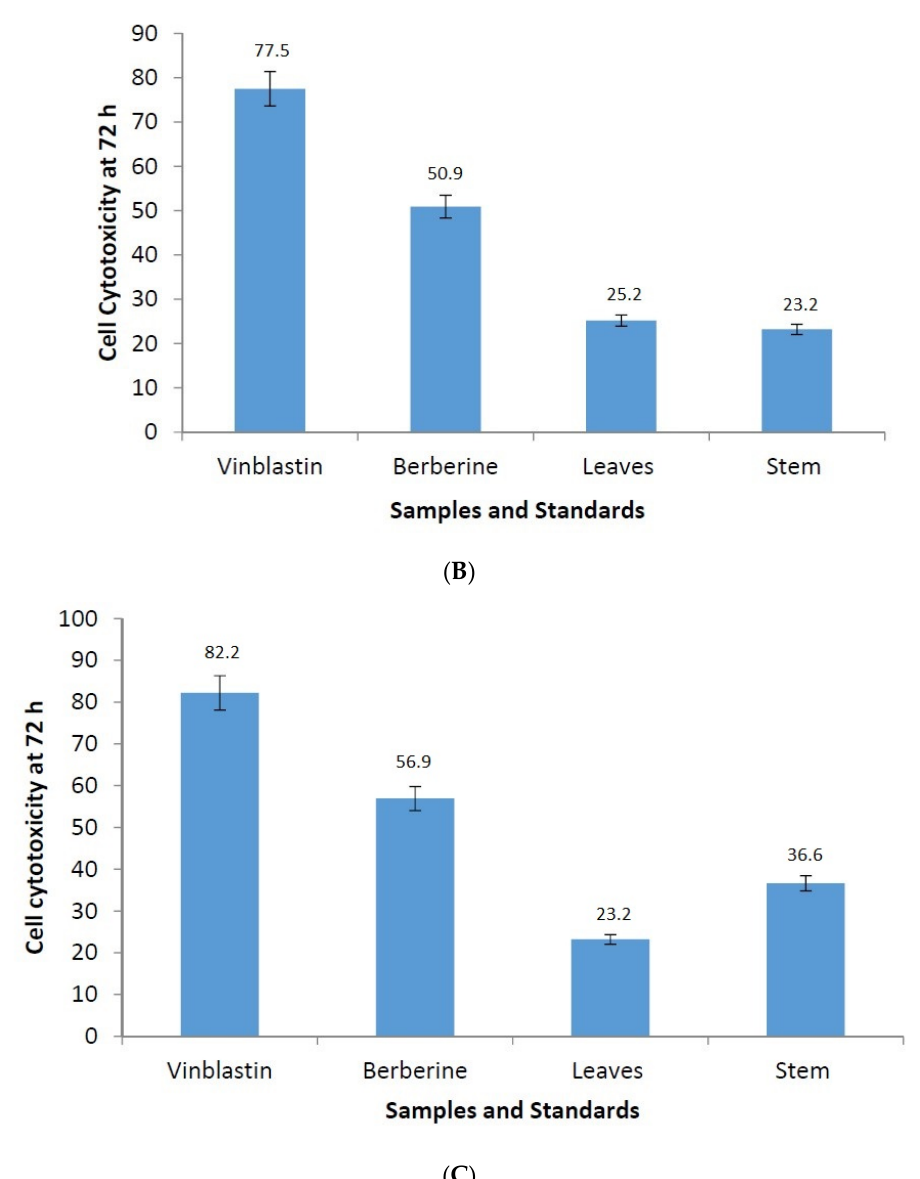
Figure 3. Percentage cytotoxicity of Vinblastine, pure berberine, leaf extracts and stem extracts of A. mexicana at 72 h on ( A ) human lung carcinoma cell line ‐ A549; ( B ) cervical cancer ‐ SiHa cell line; and ( C ) oral cancer ‐ KB cell line. Three rounds of experiments were carried out with Vinblastine 20 µ g/well, Pure berberine, Leaves and Stem extracts each with 300 μ g/well. The bars on each histograms denote standard error.